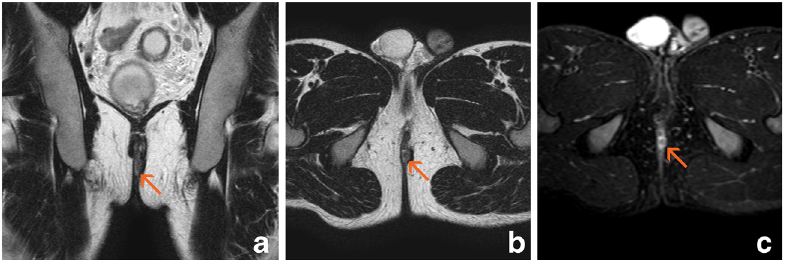
Fig. 7 Cutaneous flap showing hyperintensity on T2-weighted images and a slight post-gadolinium rim enhancement (arrows). a Oblique- coronal T2-weighted image. b Oblique-transverse T2-weighted image.